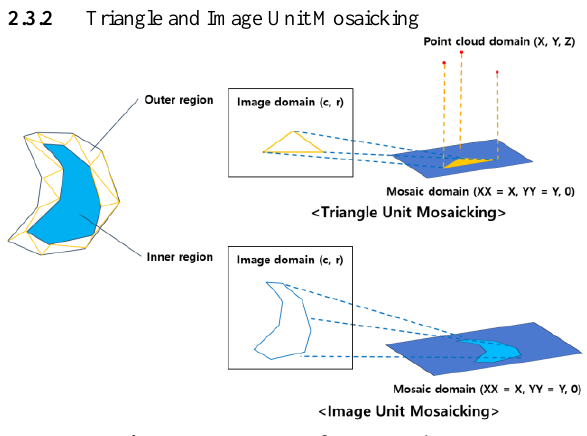
Figure 8. Concept of TUM and